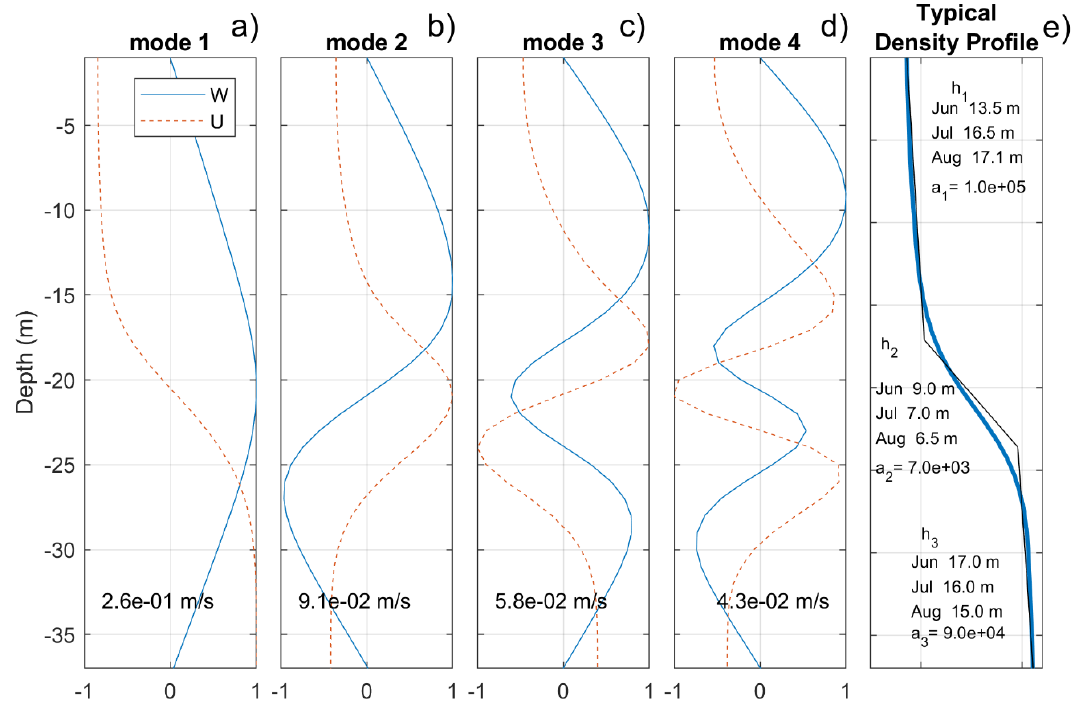
Figure 20. Normalized eigenvectors for the vertical normal modes of oscillation. From ( a – d ), vertical velocity is shown in solid line and horizontal velocity in dashed line with its corresponding phase speed (inverse of the eigenvalue). The characteristics for the three-layer theory is shown in ( e ), a typical density profile (blue line) showing the width of the epilimnion, metalimnion and hypolimnion (h i ) and a slope parameter (a i ) for June, July and August 2018.